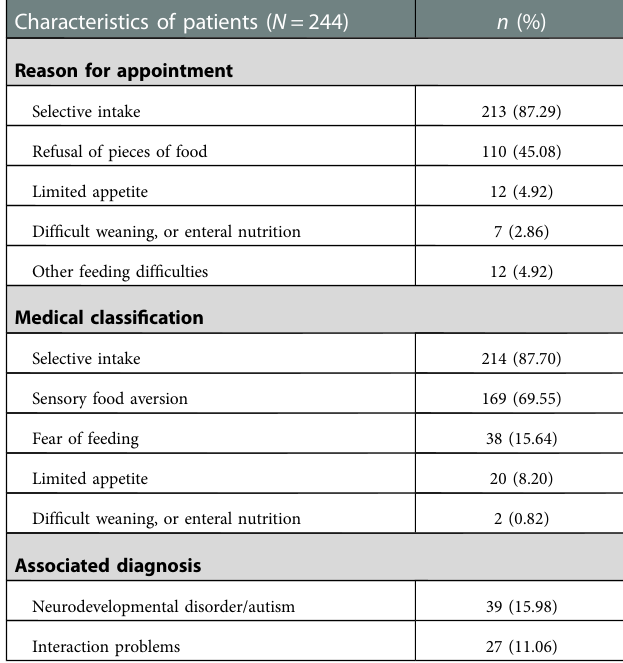
TABLE 1 Reasons for appointments, classi fi cation of feeding disorders after multidisciplinary examination, and associated diagnoses. Characteristics of patients ( N =